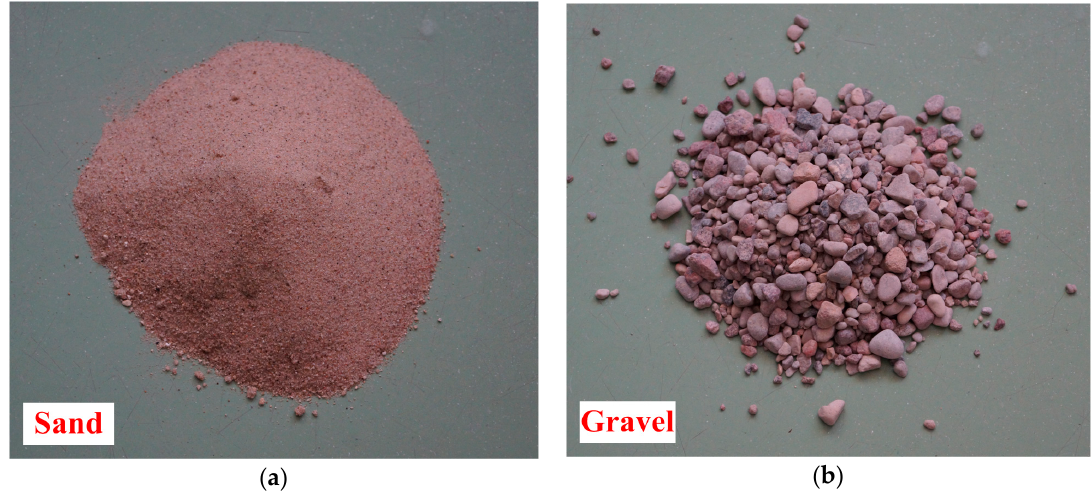
Figure 3. Aggregates used in the studies: ( a ) Sand; ( b ) gravel.